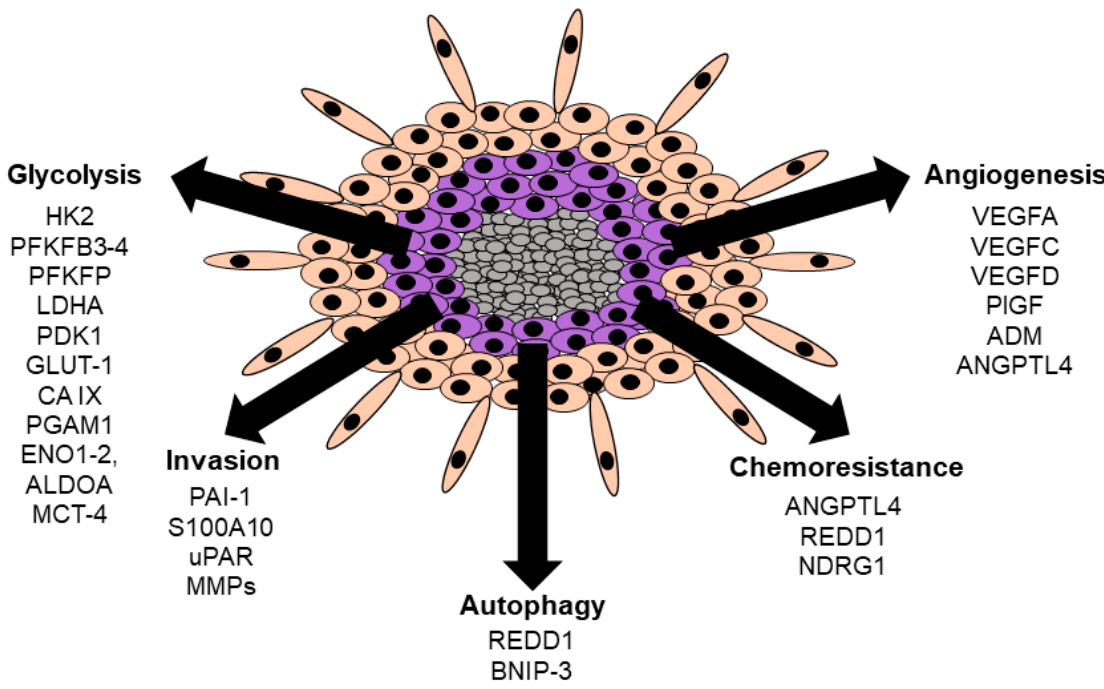
Figure 4. Hypoxia induced gene/protein expression in GB cells. Necrotic cells are represented in grey, hypoxic cells are represented in purple, and normoxic cells are represented in peach color.